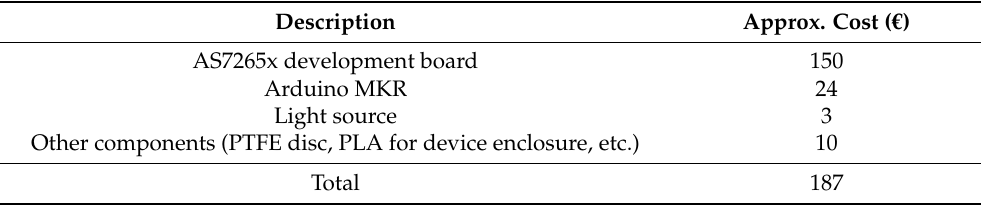
Table 1. List of the developed device components and associated cost.